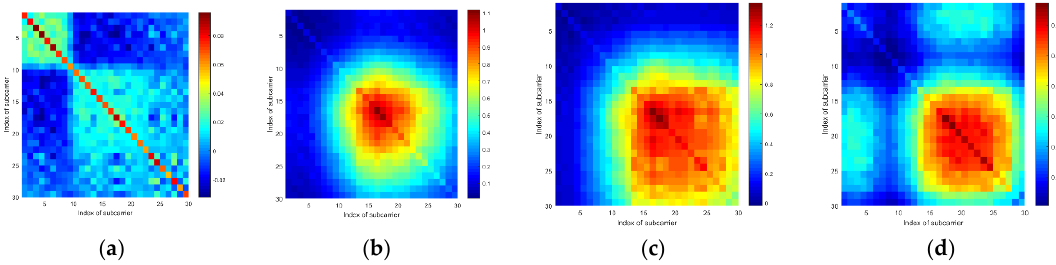
Figure 5. The mean vectors of a communication link tested at 4 locations for ( a ) the CSI amplitude and ( b ) the CSI sanitized phase.